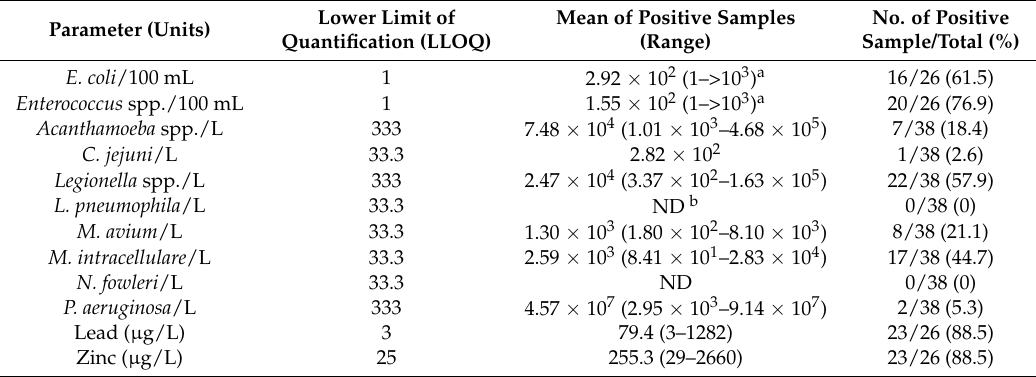
Table 2. Concentrations of FIB and pathogens and occurrence of metals in water samples collected from roof-harvested rainwater barrels (RHRB) in 2014 and 2016.